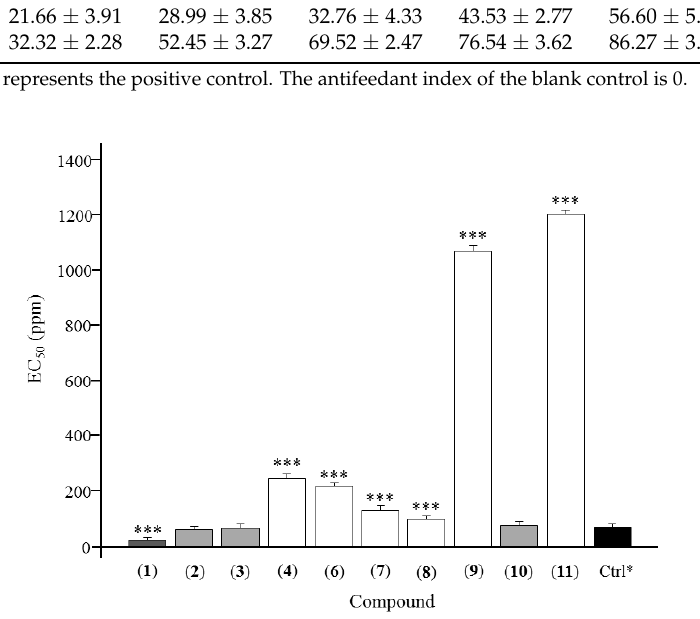
Figure 2. Antifeedant EC 50 of 10 lignans from Zanthoxylum armatum. * represents the positive control, toosendanin. *** represents the significant difference at p < 0.05.